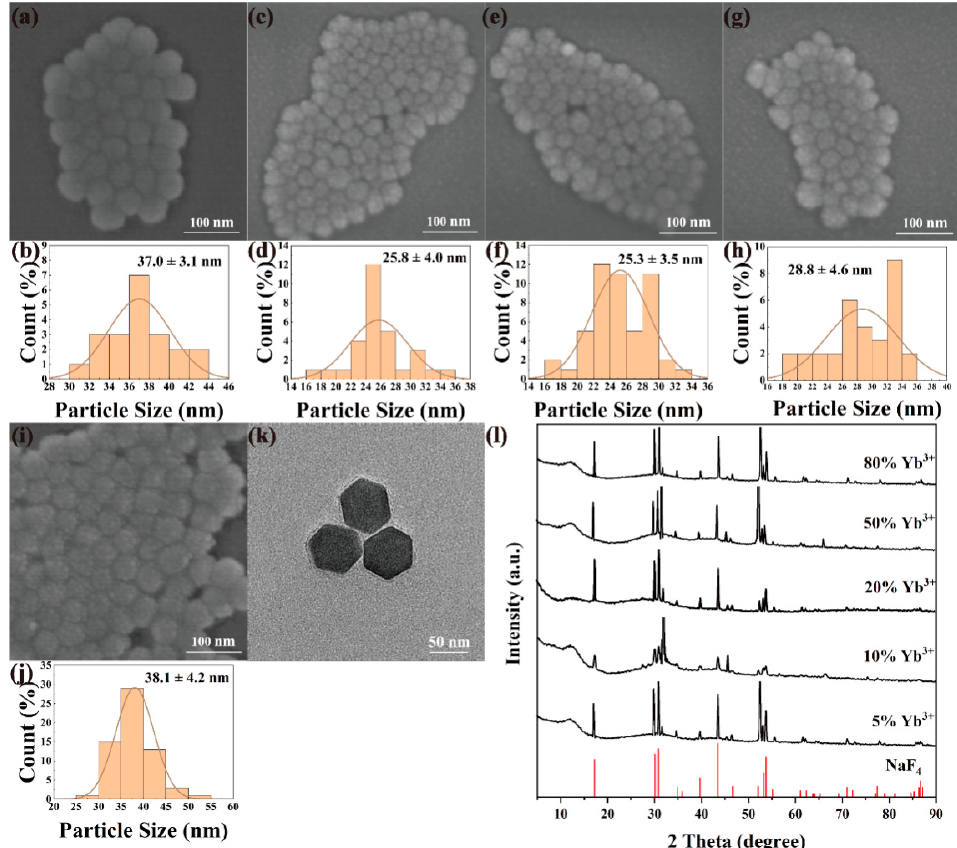
Figure 2. SEM, particle size analysis, TEM and XRD images of NaYF 4 : x%Yb 3+ , 0.5%Tm 3+ . SEM: ( a ) x = 5, ( c ) x = 10, ( e ) x = 20, ( g ) x = 50, ( i ) x = 80; particle size analysis: ( b ) x = 5, ( d ) x = 10, ( f ) x = 20, ( h ) x = 50, ( j ) x = 80; ( k ) TEM image of NaYF 4 : 20%Yb 3+ , 0.5%Tm 3+ ; ( l ) XRD of NaYF4:x%Yb 3+ , 0.5%Tm 3+ (x = 5, 10, 20, 50,